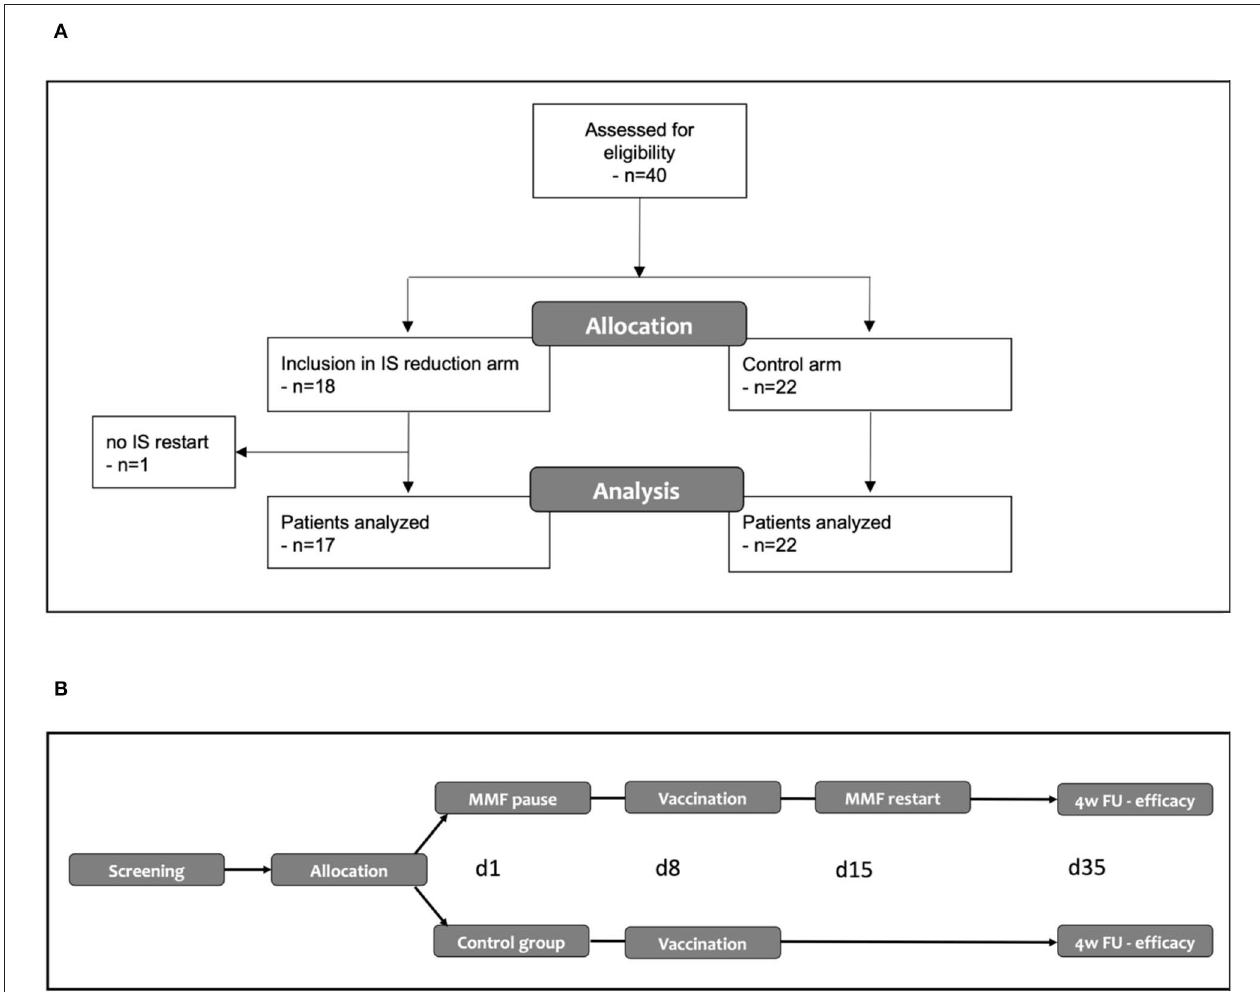
FIGURE 1 | (A) Modified CONSORT flow diagram. (B) Overview of the study. IS, immunosuppression.